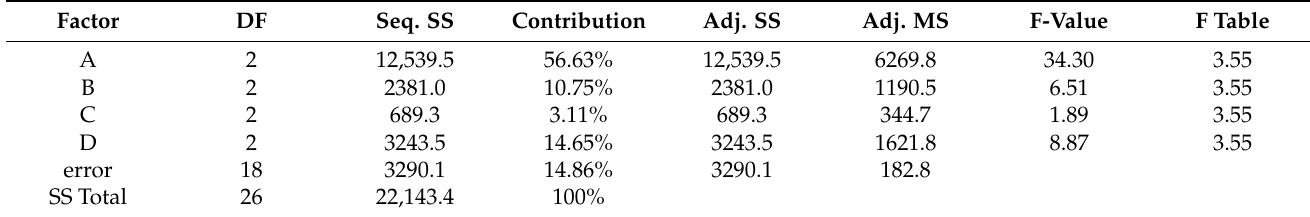
Table 5. Analysis of variance for